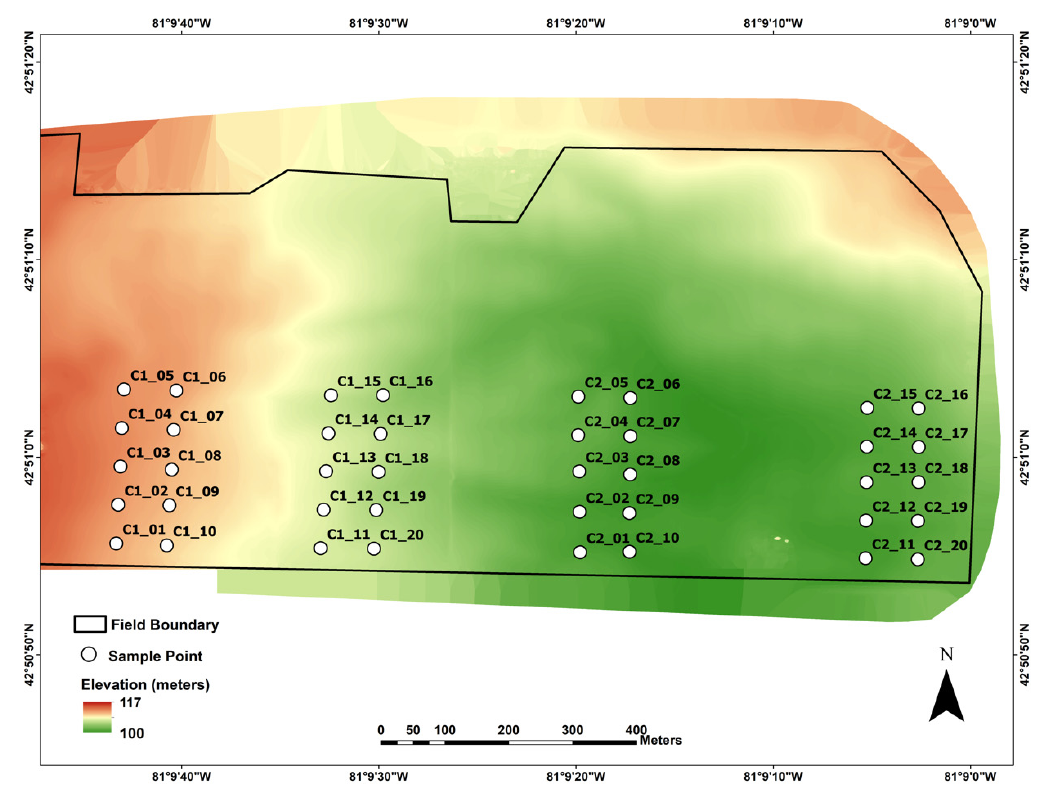
Figure 2. Digital elevation model demonstrating the variation of the corn field’s topography and the distribution of sample points.